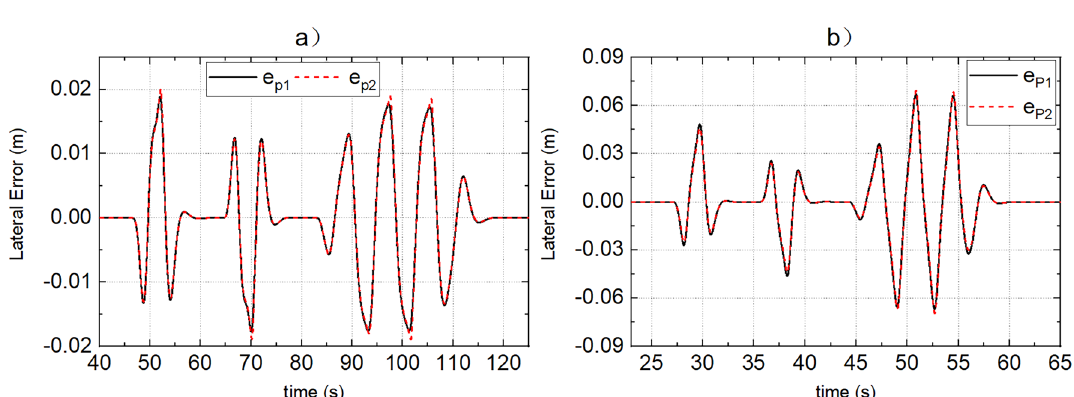
Figure 12. ( a , b ) Show the path following error when the road adhesion coefficients are 0.15 and 0.8, respectively. Curve 1 represents the SCS effect, and curve 2 represents the MMCCS